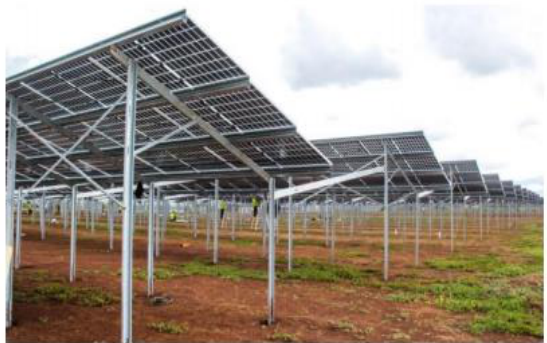
Figure 1. PV system with bi-facial modules.